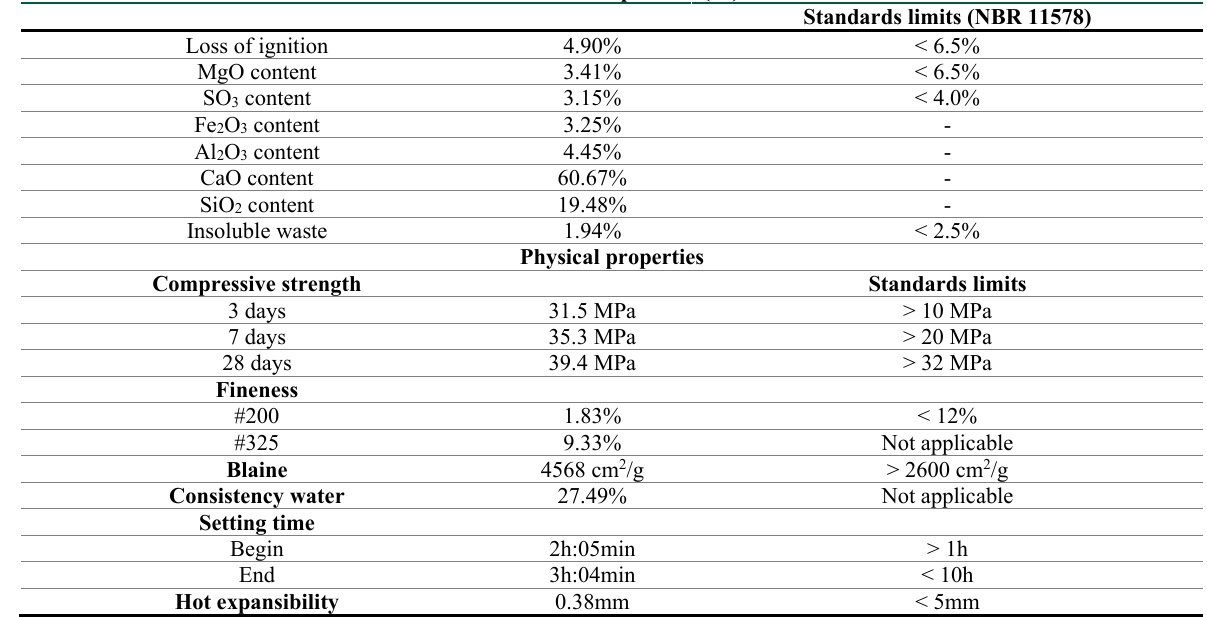
Table 1. Chemical and physical characteristics of used cement.